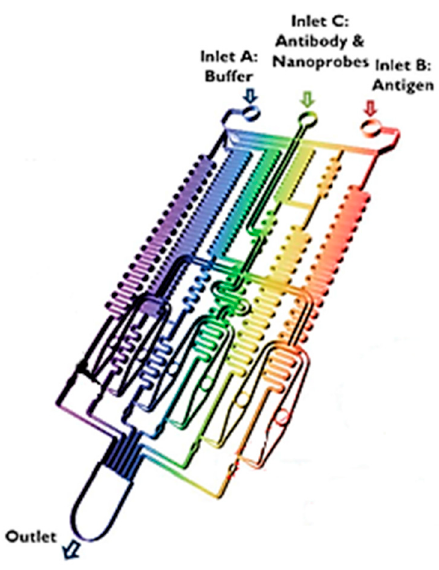
Figure 13. Layout of the gold array-embedded gradient chip. (Re-printed from Lee et al. [117]. Copyright (2020), with permission from The Royal Society of Chemistry).